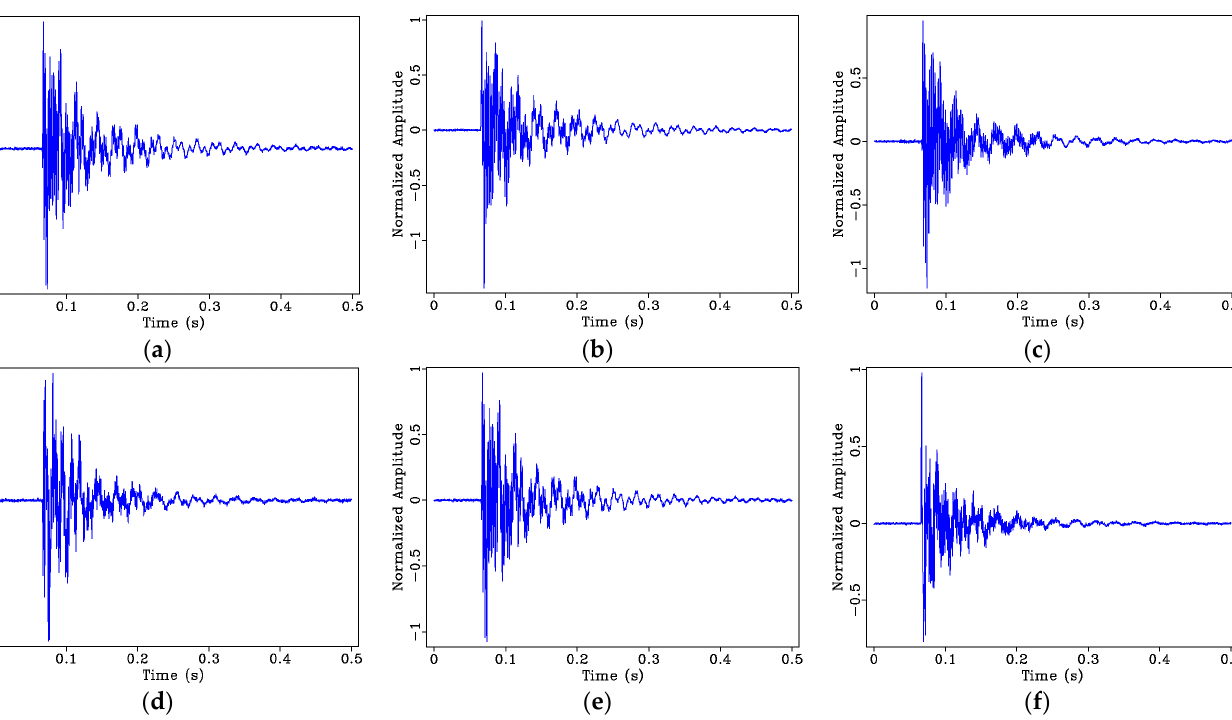
Figure 11. Normalized pre-damage acceleration response signals (time domain): ( a ) un8-2; ( b ) un8-8; ( c ) un8-14; ( d ) un14-2; ( e ) un14-8; ( f ) un14-14. The DFT was performed on the above time-domain signals, and the frequency distributions and amplitude value changes of the response signal in the frequency domain were studied. Figure 12 reveals that the main frequency components with higher amplitude in the acceleration response signals are generally distributed in the range of 0 to 1 kHz.